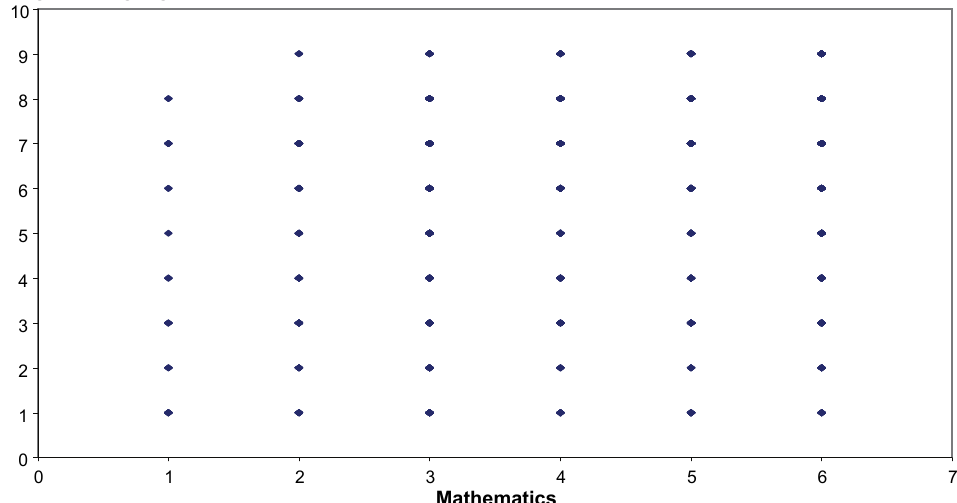
Figure 3: Scatter plot of the GCE 2006 national English Language and Mathematics